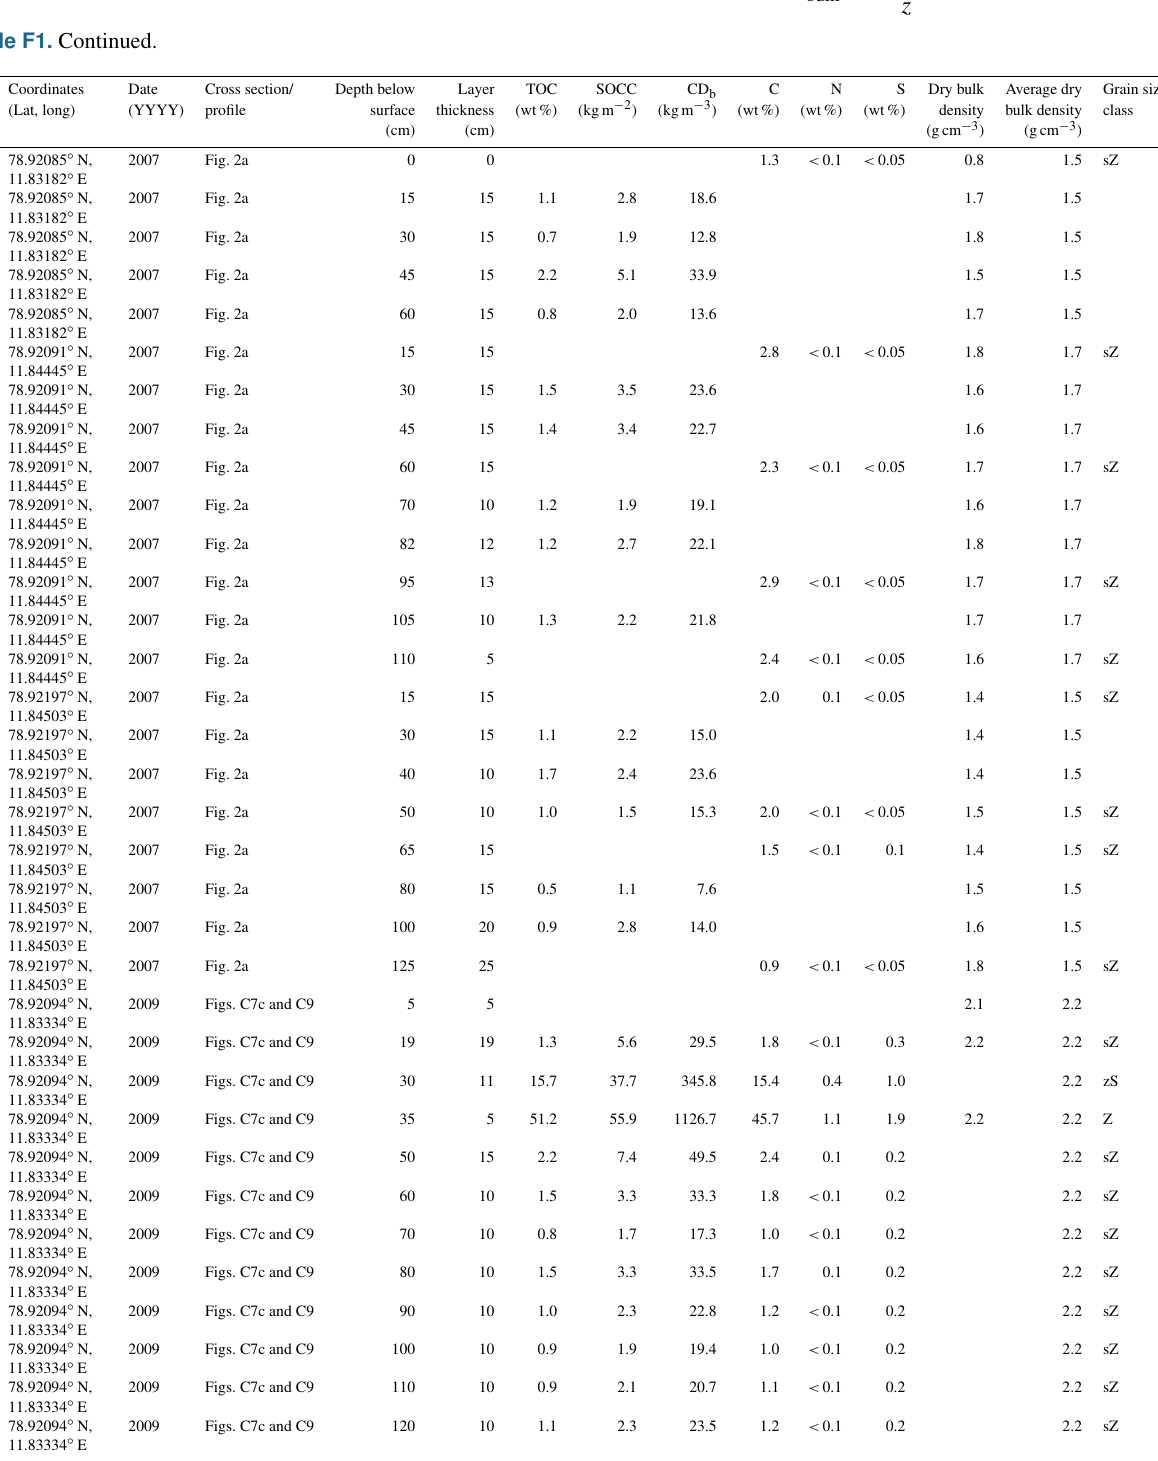
Figs. C7c and C9